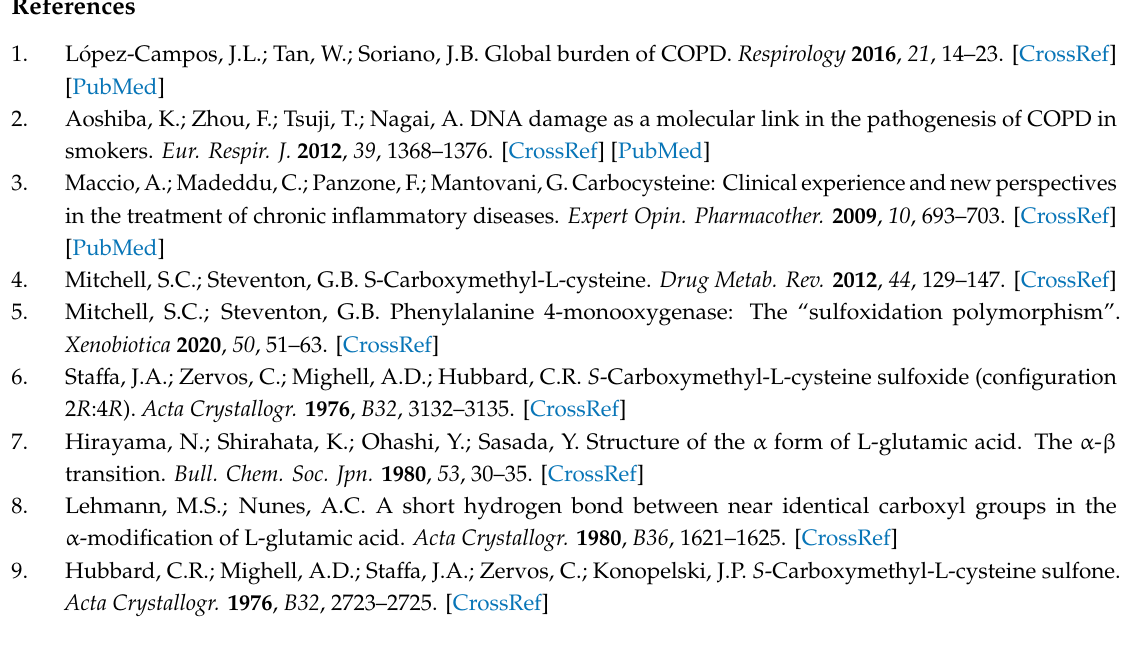
m-(4 S )-CMCO; Figure S5: Interaction energies in crystal structure of o-(4 R )-CMCO; Figure S6: Interaction energies in crystal structure of m-(4 S )-CMCO; Figure S7: Energy framework for pairwise interactions in t-(4 R )-CMCO; Figure S8: Energy framework for pairwise interactions in o-(4 R )-CMCO; Figure S9: Energy framework for pairwise interactions in m-(4 S )-CMCO; Table S1: Crystal data, data collection, and structure refinement details; Table S2: Fractionalatomiccoordinatesand isotropicor equivalentisotropic displacementparametersfort-(4 R )-CMCO;Table S3: Atomic displacement parameters for t-(4 R )-CMCO; Table S4: Bond distances and angles for t-(4 R )-CMCO; Table S5: Hydrogen-bond geometry t-(4 R )-CMCO; Table S6: Fractional atomic coordinates and isotropic or equivalent isotropic displacement parameters for o-(4 R )-CMCO; Table S7: Atomic displacement parameters for o-(4 R )-CMCO; Table S8: Bond distances and angles for o-(4 R )-CMCO; Table S9: Hydrogen-bond geometry o-(4 R )-CMCO; Table S10: Fractional atomic coordinates and isotropic or equivalent isotropic displacement parameters for m-(4 S )-CMCO; Table S11: Atomic displacement parameters for m-(4 S )-CMCO; Table S12: Bond distances and angles for m-(4 S )-CMCO; Table S13: Hydrogen-bond geometry m-(4 S )-CMCO. The complete crystallographic data for the structural analysis have been deposited with the Cambridge Crystallographic Data Centre, CCDC ## 2027234, 2027235, 2027236. Copies of this information may be obtained free of charge from the